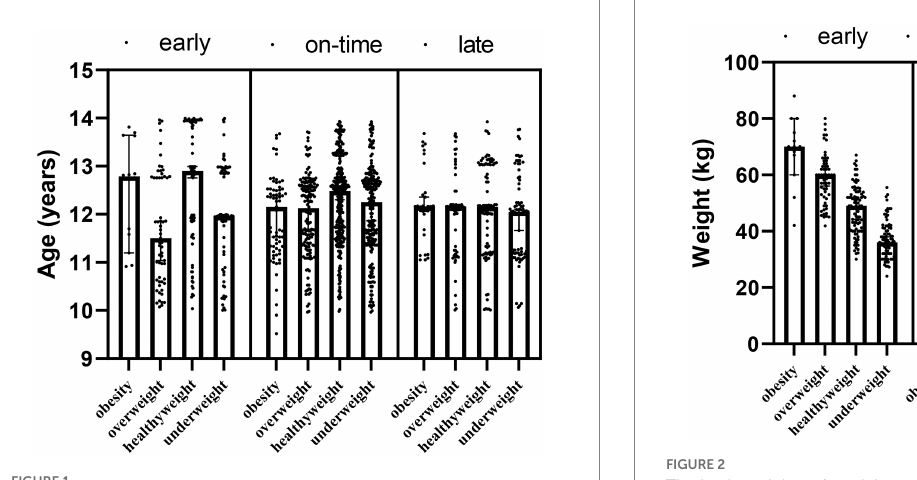
FIGURE 2 The body weights of participants according to maturity and obesity groups.